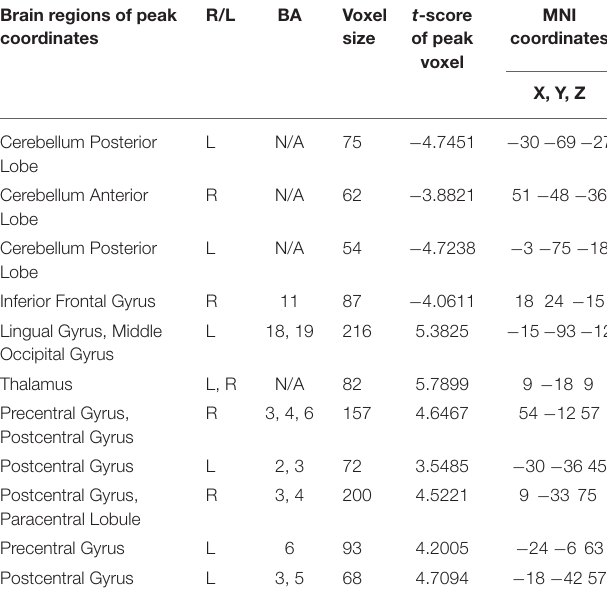
TABLE 1 | The binarized shortFCD differences between SD and RW. Brain regions of peak coordinates